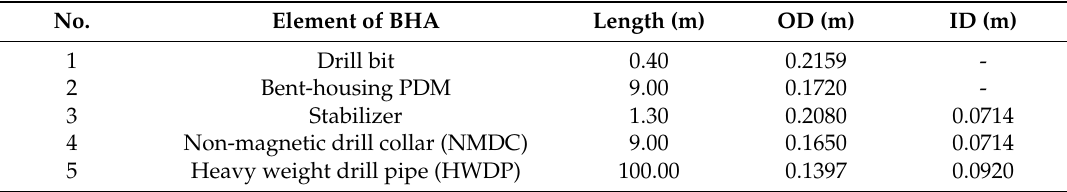
Table 2. Geometric parameters of the bottom hole assembly (BHA)